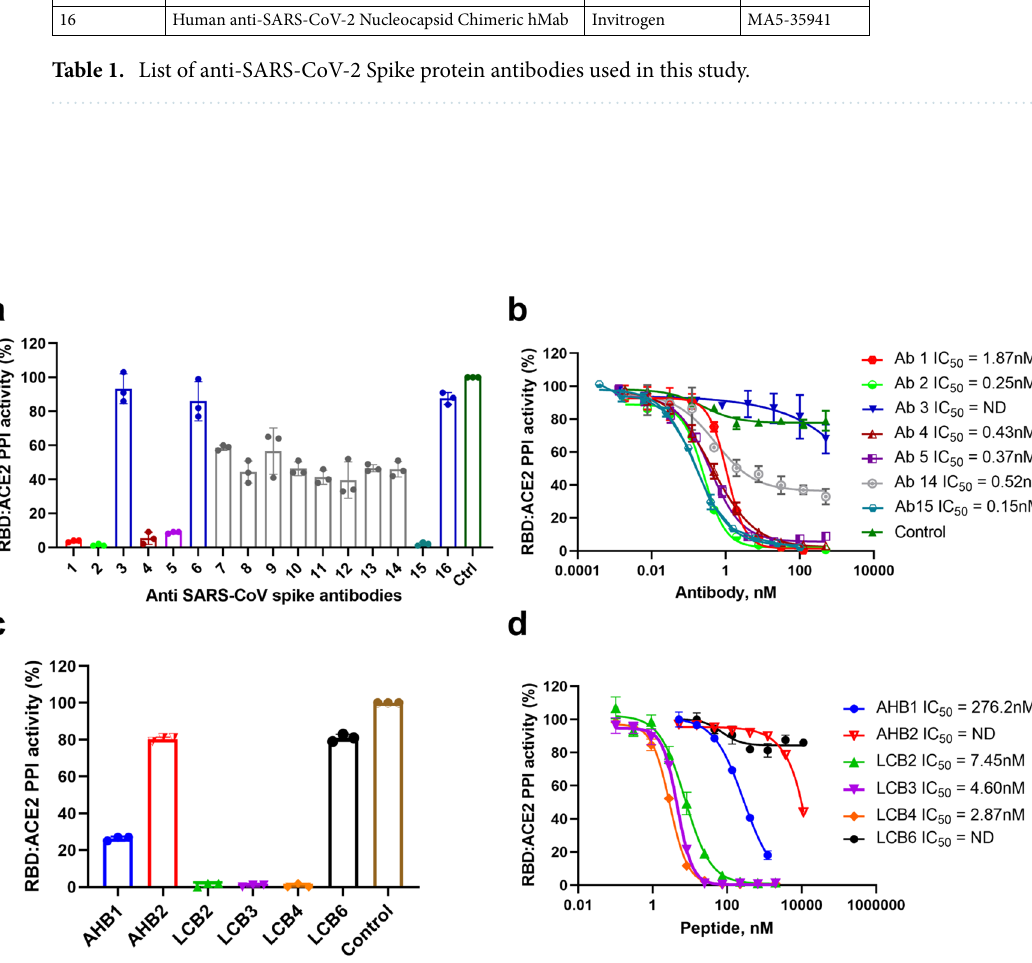
Figure 3. Discovery and characterization of Spike RBD:ACE2 inhibitory molecules. ( a ) Antibody screening. Anti-SARS-CoV-1 and 2 Spike antibodies were tested at 55 nM. Anti-SARS-CoV-2 Nucleocapsid (NP) antibody (#16) was used as a control for specificity and the absence of antibody (Ctrl) was used for 100% activity. ( b ) Antibody dose response experiments. Monoclonal antibodies were serially diluted and incubated with SARS- CoV-2 Spike RBD-rabbit Fc for 30 min prior to the addition of hACE2-mouse Fc and Lumit antibodies. ( c ) Inhibitory peptides were tested at 1 µM for their ability to disrupt the RBD:ACE2 interaction and the absence of peptide (Ctrl) was used for 100% activity. ( d ) Peptides were serially diluted and incubated with SARS-CoV-2 Spike RBD-rabbit Fc for 30 min prior to the addition of hACE2-mouse Fc and Lumit antibodies. The antibodies and peptides in b and d were tested with either RBD-Fc and Lumit Anti-Rabbit antibodies, or with hACE2-Fc and Lumit Anti-mouse antibodies and showed no interference with NanoBit luciferase activity. Results are presented as means ± S.E.M. (n = 3 technical replicates, the data are representative of two or more